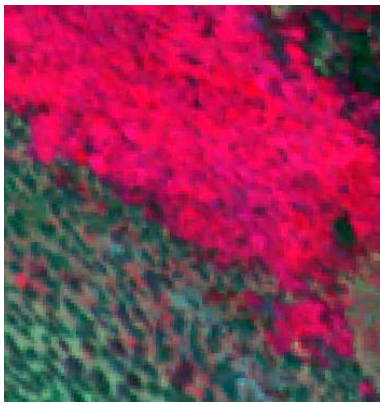
Figure 5. Part of the MS image.